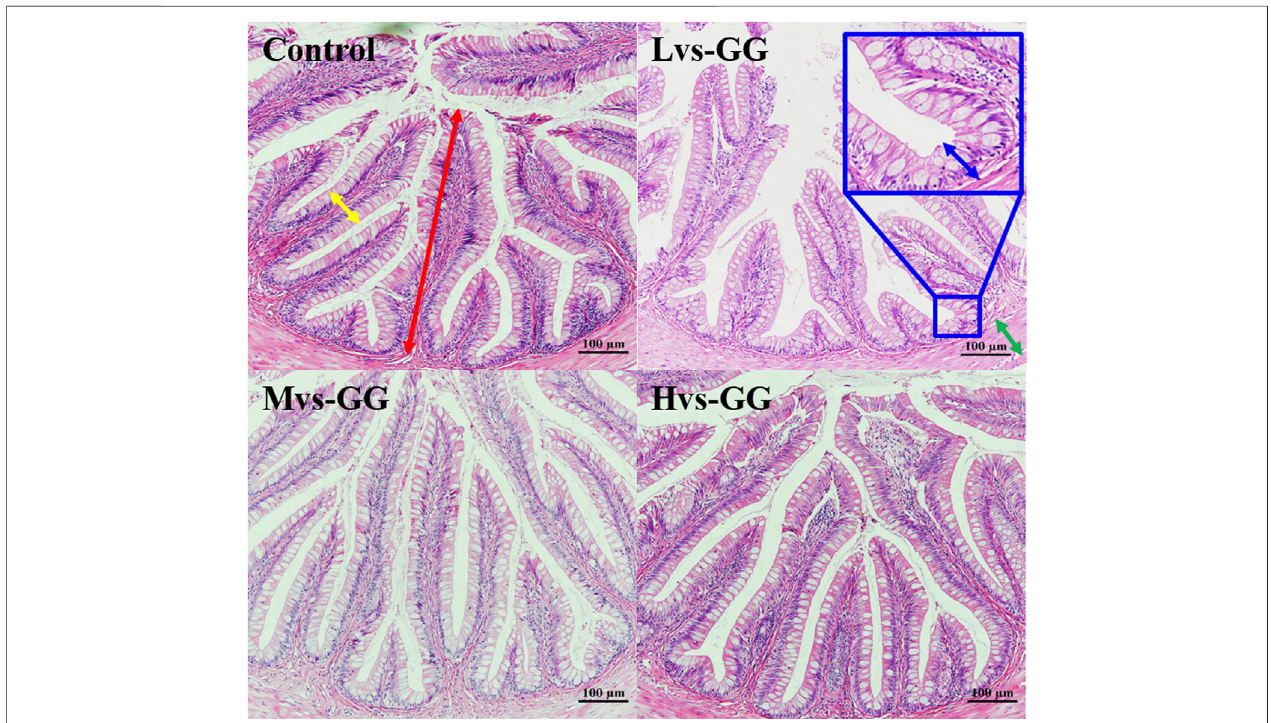
FIGURE 1 | Effects of increasing dietary guar gum viscous on hindgut morphology of juvenile largemouth bass (H&E staining, magni fi cation ×200). Yellow double- sidearrow:villuswidth;Reddouble-sidearrow:villusheight;greendouble-sidearrow:muscularisthickness;bluedouble-sidearrow:cryptdepth;bluearrow:gobletcell.